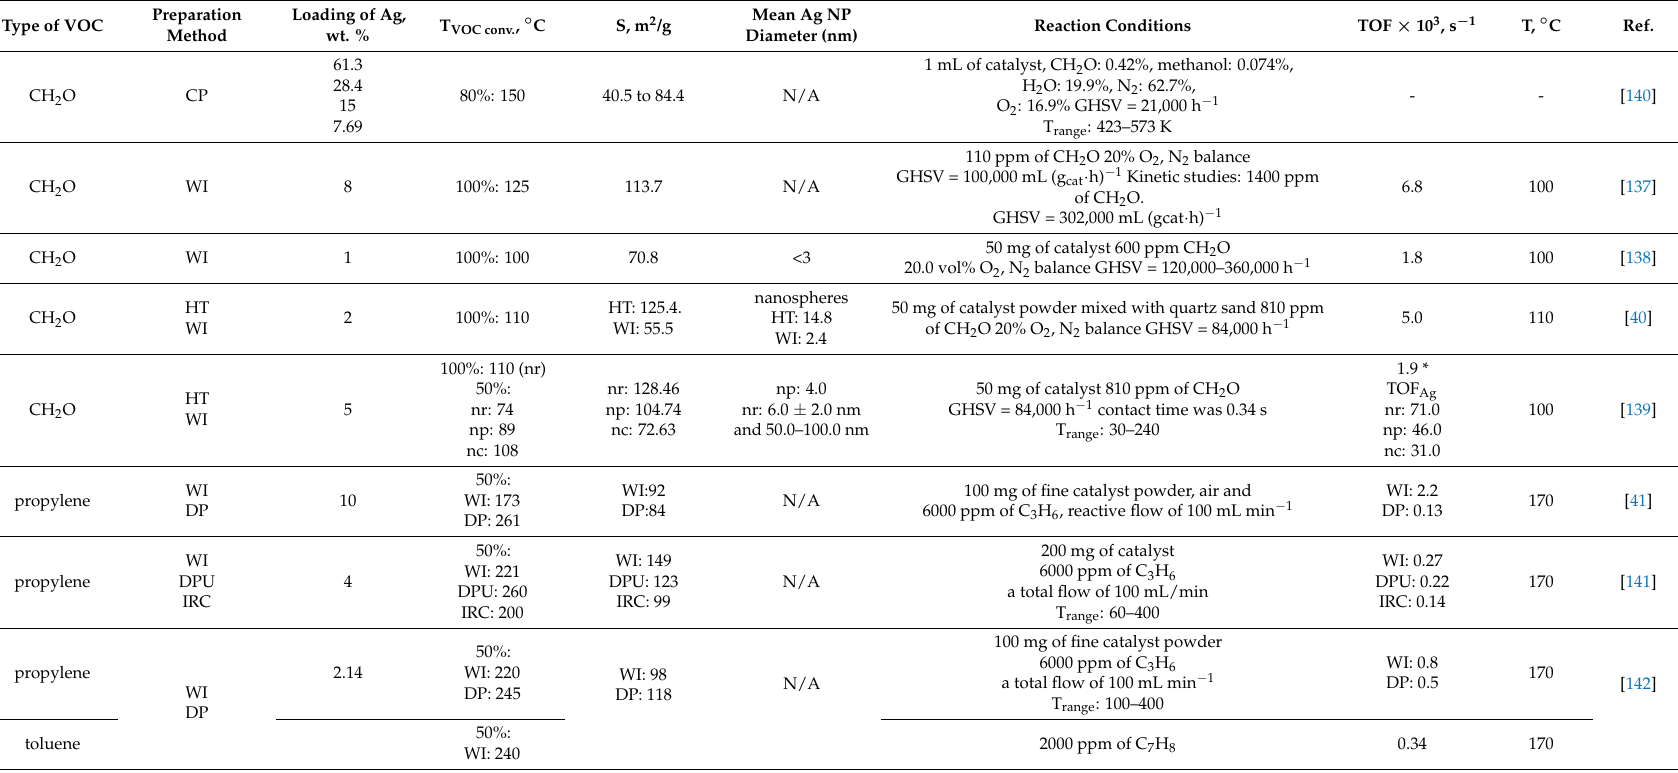
Table 2. Literature data on catalytic VOCs abatement over Ag/CeO 2 composite